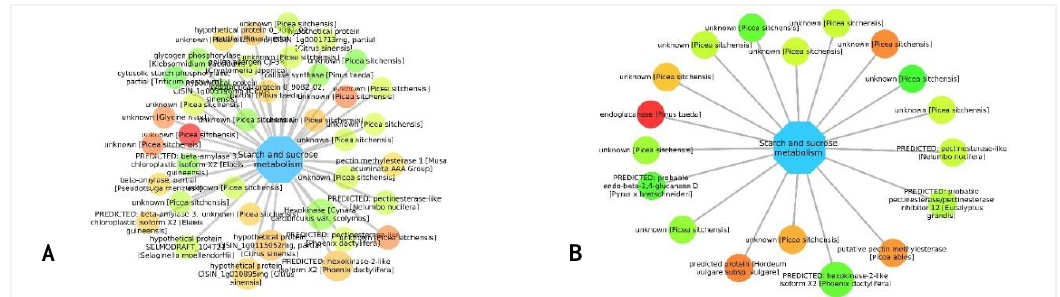
Figure 13. Starch and sucrose metabolism pathway with interactions assigned to DEG in Pinus pinaster ( A ) and in Pinus yunnanensis ( B ) at the third time point after inoculation (7 days). The blue node represents the pathway. The circular nodes represent DEG related to the pathway. Note that due to the complexity of representing the expression values of those genes in all the stages, the expression was colored on an RGB scale that goes from the most down-regulated in red to the most up-regulated in green.